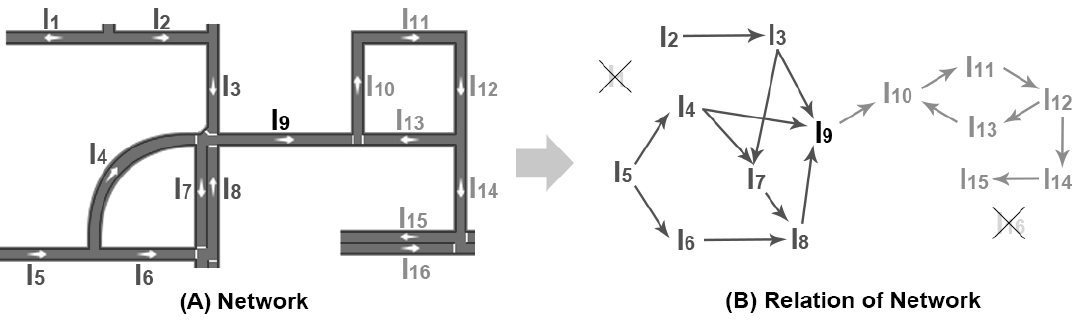
Figure 2. Relation and bound of the network.